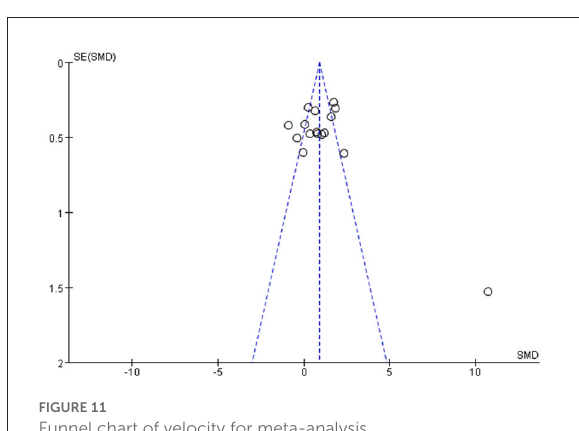
FIGURE11 Funnel chart of velocity for